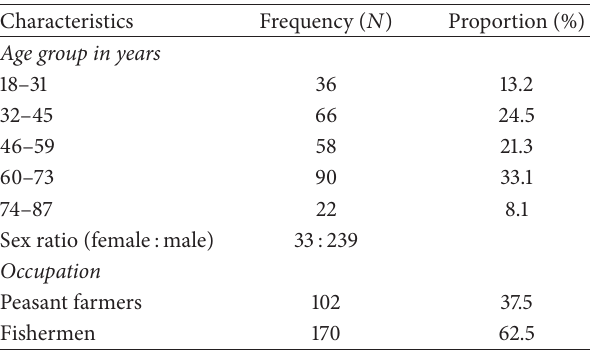
Table 1: Sociodemographic characteristics of the study